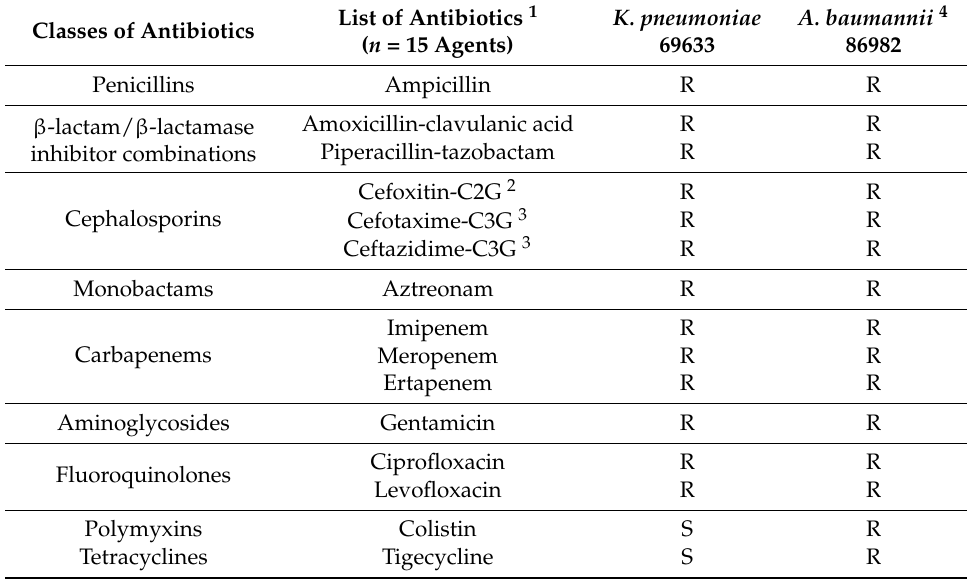
Table 1. Phenotypic characterization of the K. pneumoniae an-d A. baumannii isolates. Classes of Antibiotics